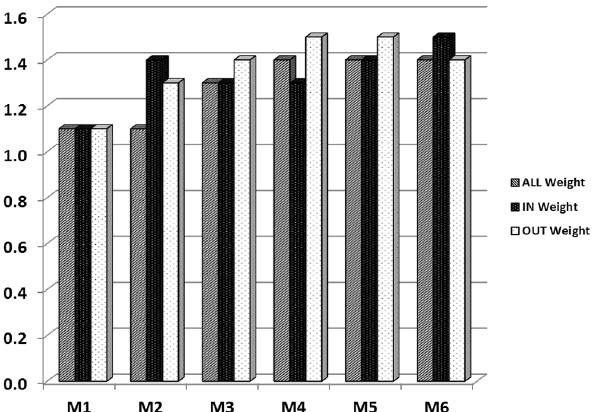
Fig. 11. Exponent of the weight distribution for networks M1–M6.